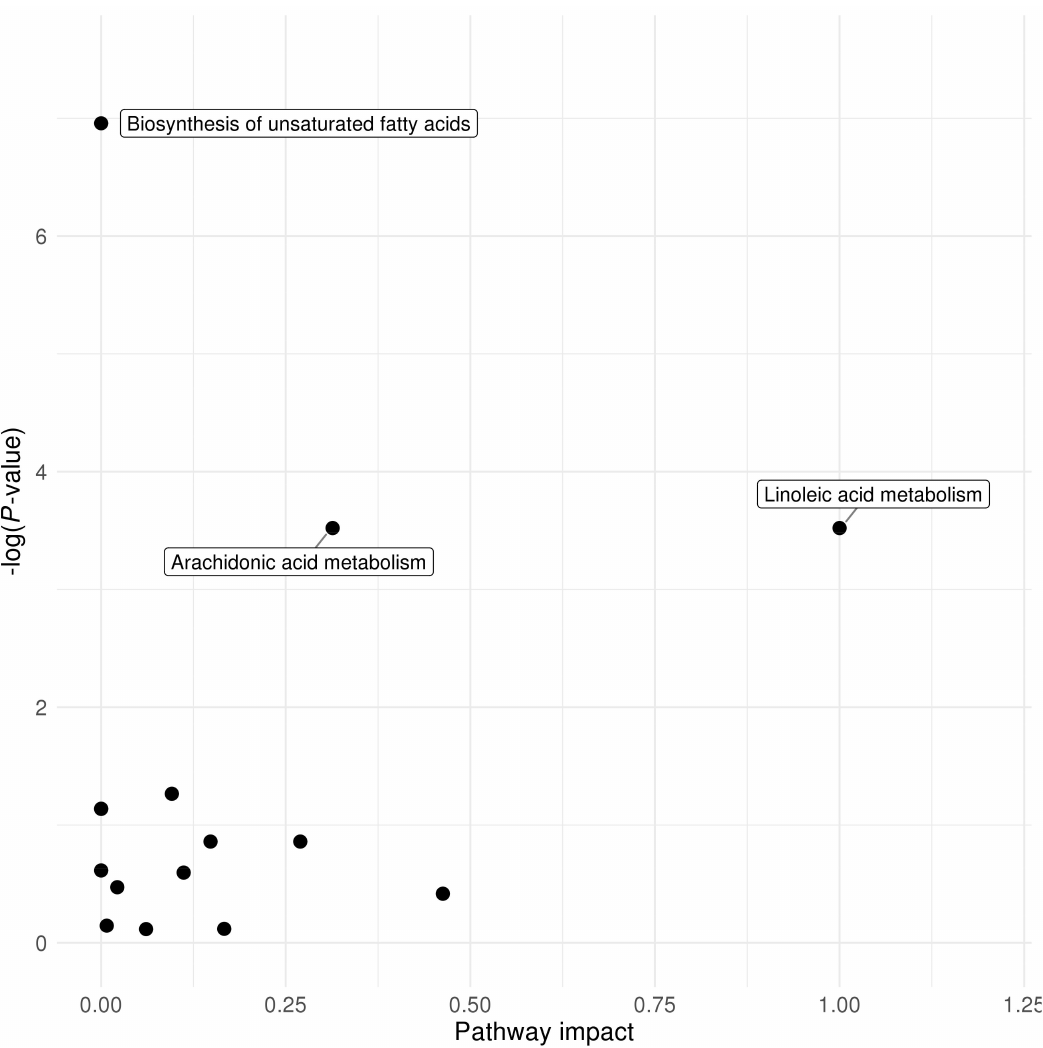
Figure 1. Pathway over-representation analysis significance against pathway impact plot for MetaboAnalyst pathway analysis results at age 1 (natural logarithm of P -value on